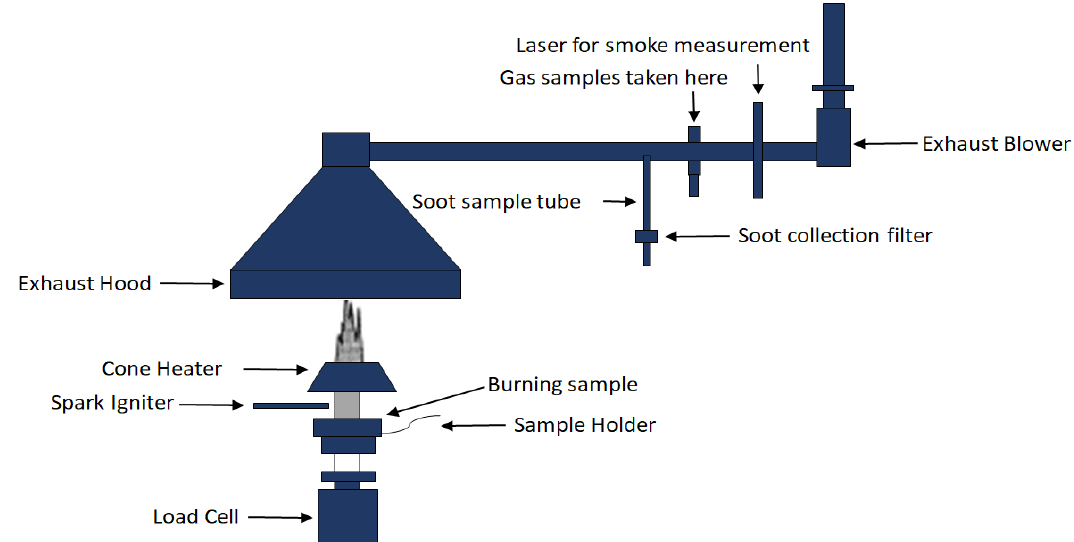
Figure 7. Schematic diagram of cone calorimetry equipment.